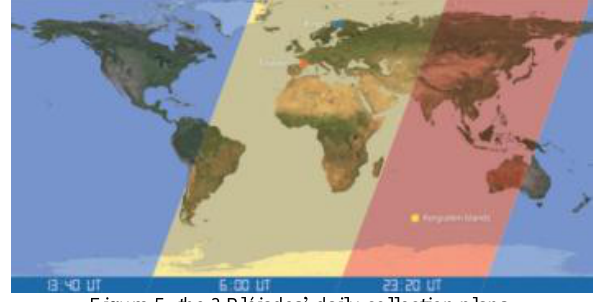
Figure 5: the 3 Pléiades’ daily collection